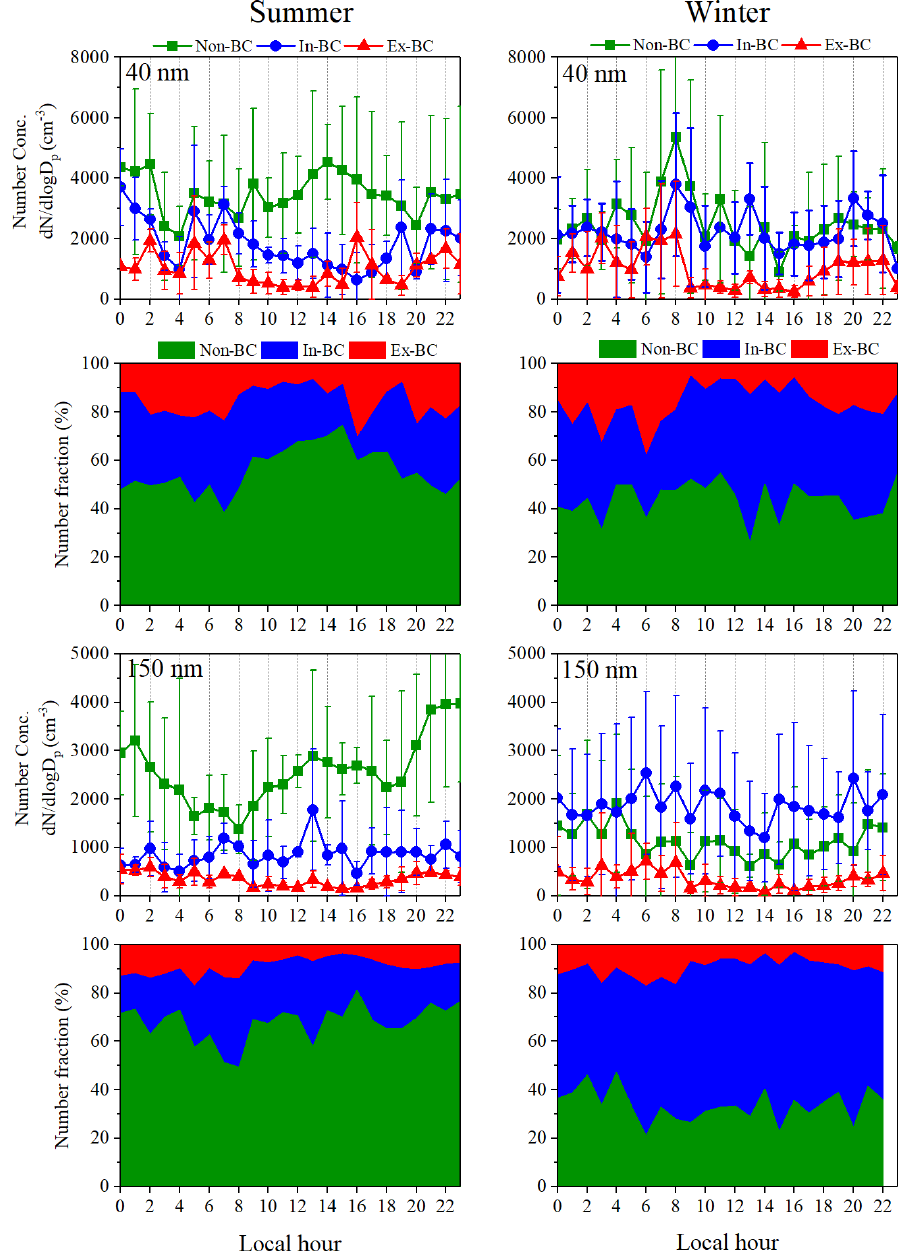
Figure 11. Average diurnal variations of retrieved number concentrations and fractions of Non-BC, In-BC, and Ex-BC of 40 and 150nm particles in the summer (left) and winter (right)